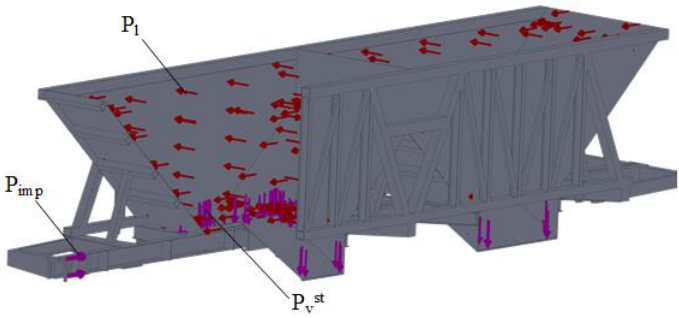
Figure 6. Calculation scheme of the hopper-wagon-supporting